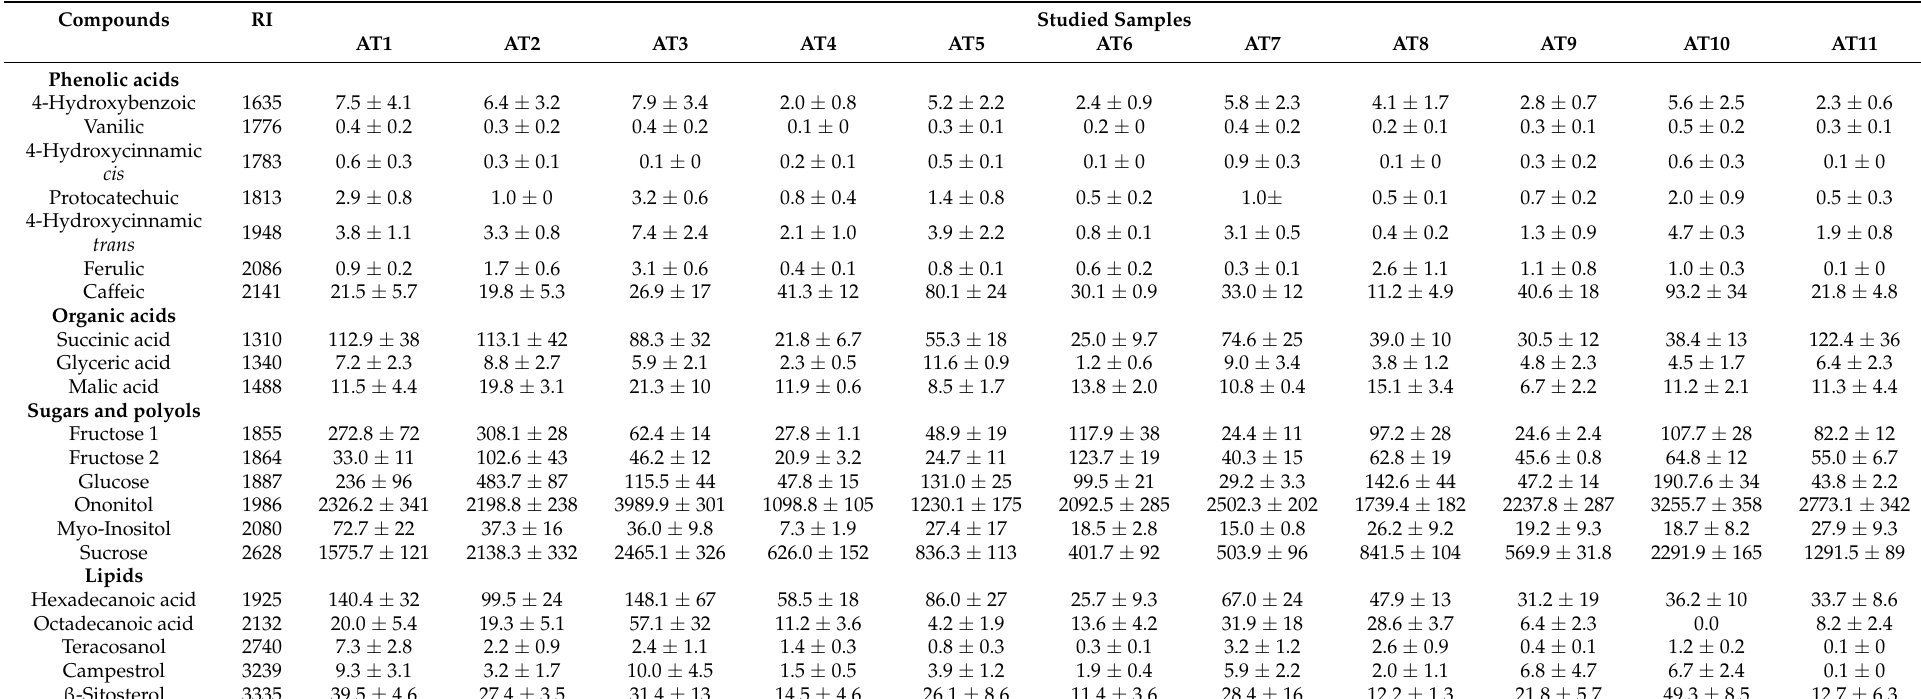
Table A2. Identified metabolites of the aerial parts of A. tinctoria by GC/MS